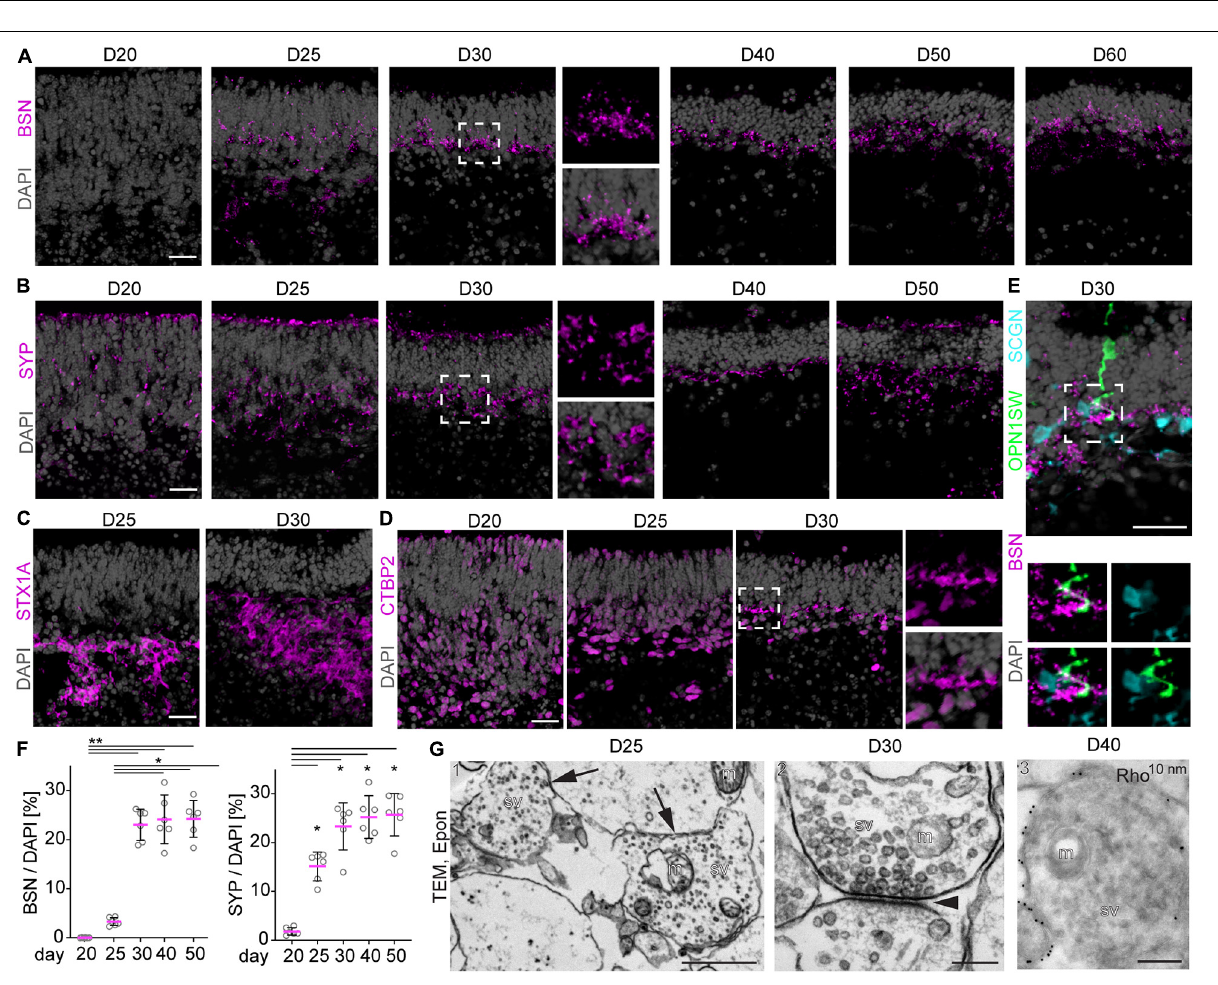
FIGURE 5 | Synapse formation in MROs. (A–E) Representative images and (F) quantitative analysis of immunostained MRO cryosection at the timepoints indicated for synaptic markers BSN, SYP, STX1A, and CTBP2. Dashed squares indicate regions shown at high magnification. (A) BSN is first detected at D25, and becomes more prominent at D30 forming a dense outer plexiform (OPL)-like layer. At later timepoints, BSN is still detected in a dotted pattern in an OPL-like layer, but the expression becomes scarce. (B) Similarly, SYP is already expressed by a few cells from D20, but becomes localized to an OPL-like layer by D30. (C) STX1A is detected in more basal regions of the MRO at D25 and D30, but no clear inner plexiform like layer could be observed. (D) CTBP2 is first detected in nuclei of the majority of basal and a few apical cells at D20–25. At D30, small stretches of non-nuclear signal are observed in the OPL-like layer, suggesting formation of synapses. (E) At D30, synaptic marker BSN is detected in close proximity to the processes of cone marker OPNSW1- and cone-bipolar marker SCGN-positive cells, suggesting the formation of synaptic contacts between photoreceptors and second order neurons (bipolar cells). Dashed square indicate region shown at high magnification. (F) For quantification, pixel area above the threshold was measured for each marker and normalized to DAPI. Each dot represents an organoid, organoids were derived from N = 2 independent experiments. * p < 0.01, ** p < 0.0001 (ANOVA). (G) Transmission electron microscopy (TEM) confirms the formation of synapses in D25 (1), D30 (2) and D40 (3) MROs. (G1–2) epoxy resin embedded samples, (G3) Tokuyasu cryo-sections stained with anti-RHO and protein A 10 nm gold. Arrows in (G1) indicate 2 synapses, arrowhead in (G2) indicates the synaptic cleft. m, mitochondrion; sv, synaptic vesicles; D, day. Scale bars: (A–E) 25 µ